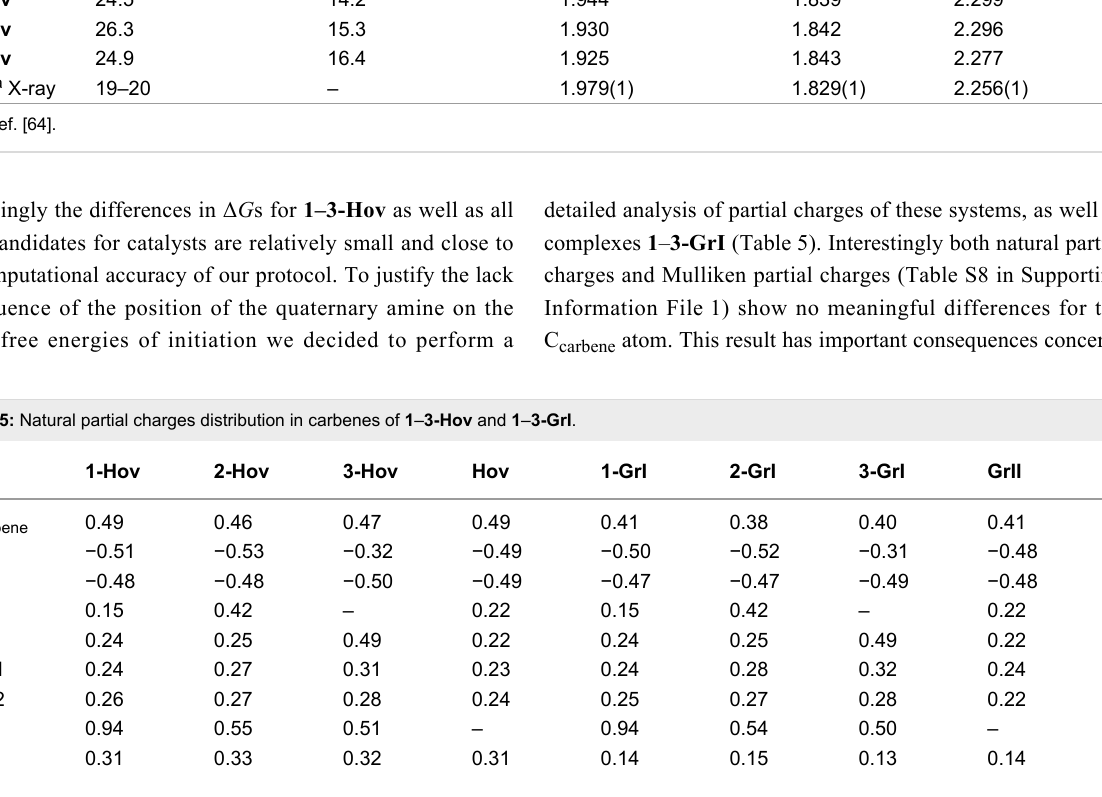
Table 4: The comparison of Gibbs free energies ∆ G 10 and ∆ G 11 and selected structural parameters of Hov and 1 – 3-Hov catalysts. complex